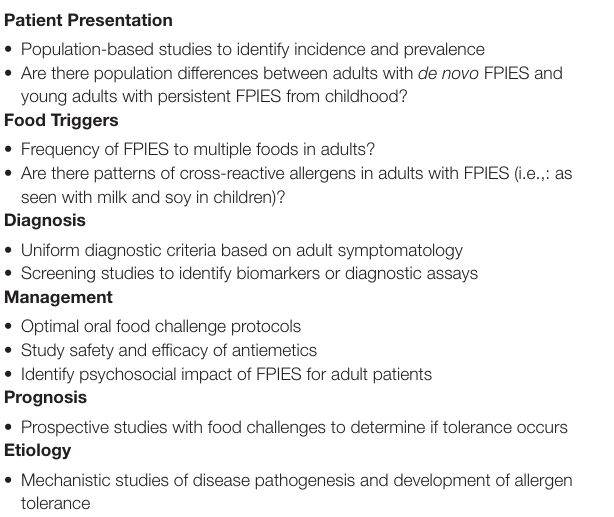
TABLE 2 | Research gaps in adult FPIES. Patient